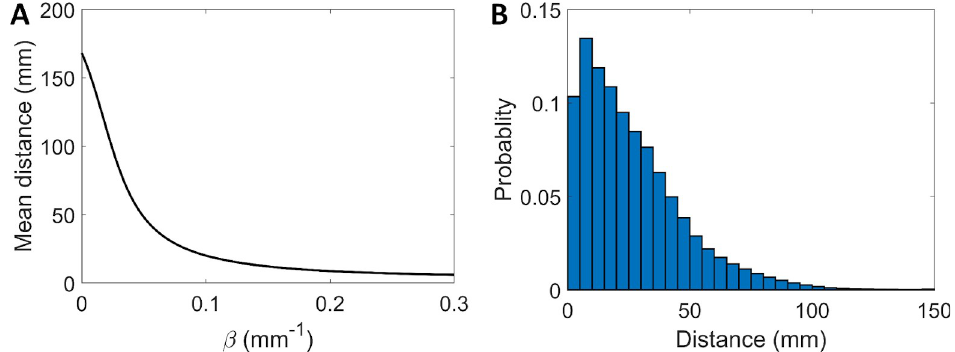
Fig 6. Lesion spreading distance. (A) Mean distance where lesions appear as a function of the dispersion parameter, β 2 [0, 0.3] mm -1 . Due to the quantization of the space, for β > 0.3 mm -1 the probability that the lesion appears at the nearest terminal is very high and the value is a constant. (B) Density of probability of new lesions spreading with β = 0.08 mm -1